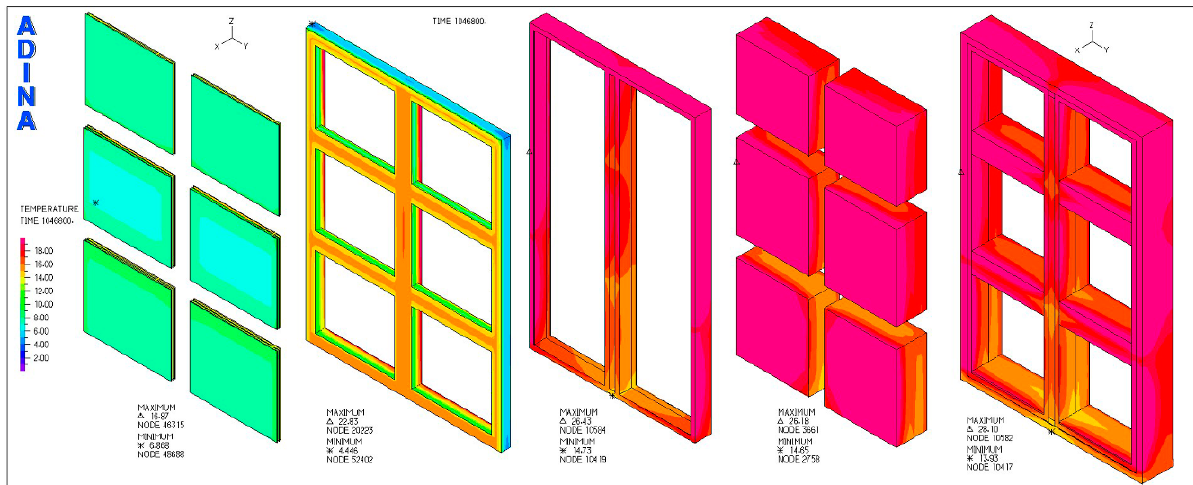
Figure 21. Graphic temperature distribution in the components of the wall at 1:00 p.m. on 23 December. From the left: collector glass, collector frame, steel frame, storage layer, housing polystyrene.